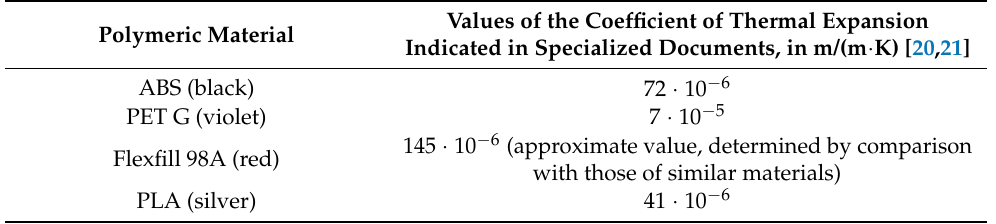
Table 1. Values of thermal expansion coefficients for materials used in experimental research. Values of the Coefficient of Thermal Expansion Polymeric Material Indicated in Specialized Documents, in m/(m · K) [20,21] ABS (black) 72 · 10 − 6 PET G (violet) 7 · 10 − 5 145 · 10 − 6 (approximate value, determined by comparison Flexfill 98A (red) with those of similar materials) PLA